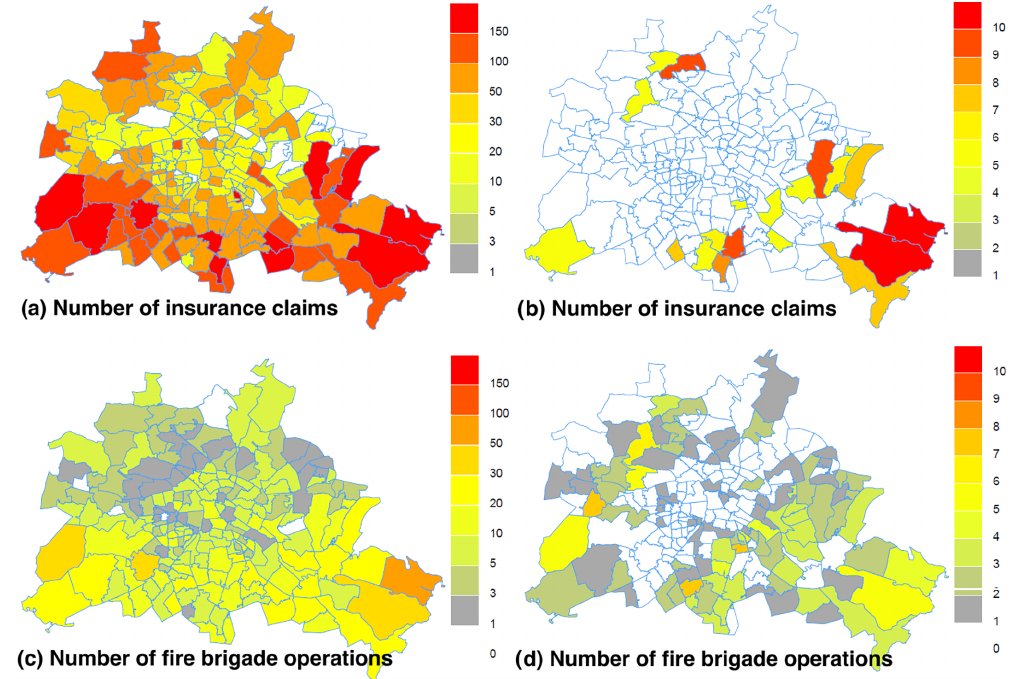
Figure 1. Spatial comparison of the number of insurance claims (a, b) to the number of fire brigade operations (c, d) for winter storm Kyrill in 2007 (a, c) and frontal passage Gunnar in 2011 (b, d) . Table 2. Spatial correlations for specific events. The correlation is calculated between the number of fire brigade operations and the number of insurance claims within individual zip code areas. Kyrill Emma Xynthia Lothar07 Aram + Gunnar + All operations 0.70 ∗∗∗ 0.20 ∗∗ 0.09 0.78 ∗∗∗ 0.57 ∗∗∗ 0.46 ∗∗∗ Water damages 0.45 ∗∗∗ − 0.05 − 0.06 0.54 ∗∗∗ 0.20** 0.06 Traffic obstruction 0.09 − 0.08 0.11 0.45 ∗∗∗ 0.16* − 0.04 Tree-related 0.73 ∗∗∗ 0.42 ∗∗∗ 0.28 ∗∗∗ 0.79 ∗∗∗ 0.79 ∗∗∗ 0.58 ∗∗∗ 0.03 − 0.04 − 0.1 0.21** 0.19* − 0.07 Others 0.06 − 0.05 − 0.01 − 0.06